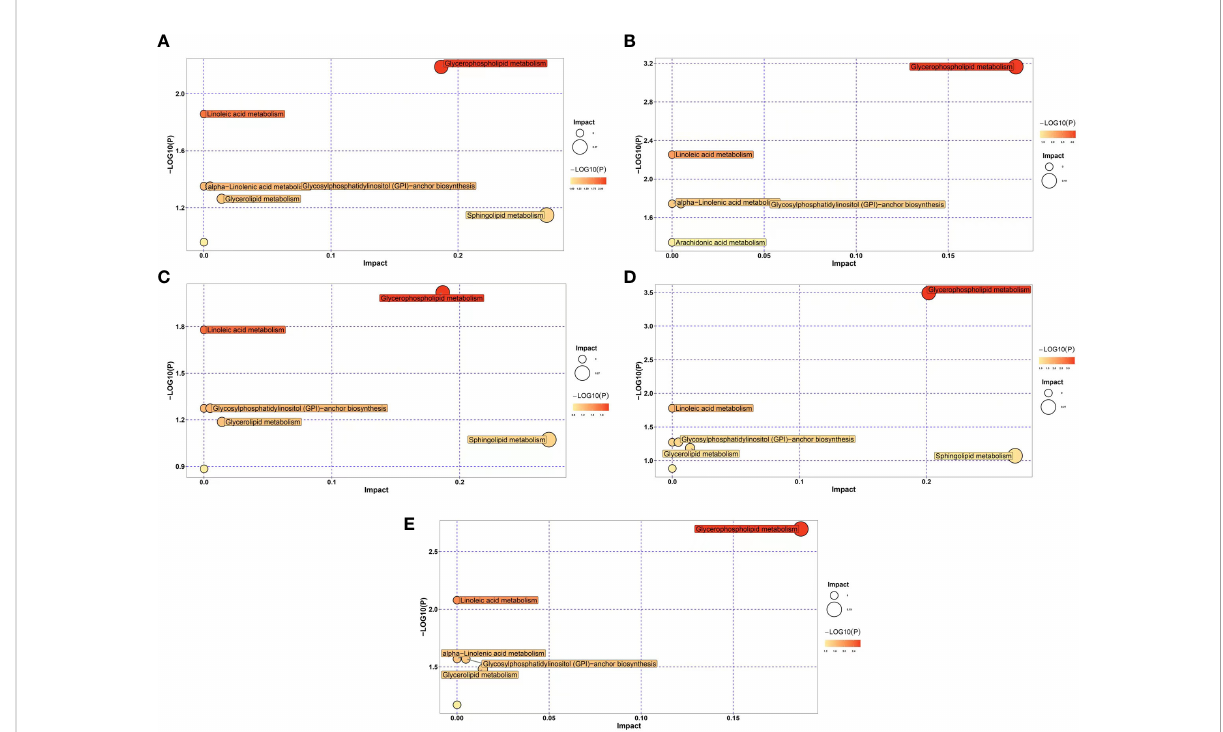
FIGURE 4 Differential expression of lipid metabolic pathways in transplanted pearl oyster P. f. martensii throughout different transplantation periods. The x- and y-axes represent pathway enrichment and pathway impact, respectively. Large sizes and dark colors represent major pathway enrichment and high pathway impact values, respectively. (A) days 0 vs. 1; (B) days 1 vs. 3; (C) days 3 vs. 7; (D) days 7 vs. 15; and (E) days 15 vs.